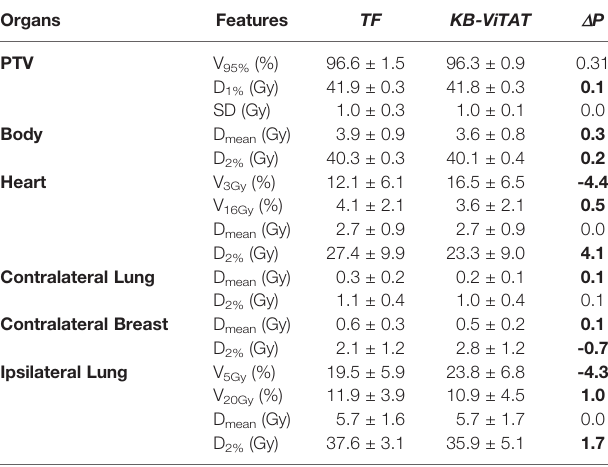
TABLE 5 | Dose-volume parameters comparison (TF vs ViTAT) for the validation cohort test of 30 plans for the left-sided breast case. Organs